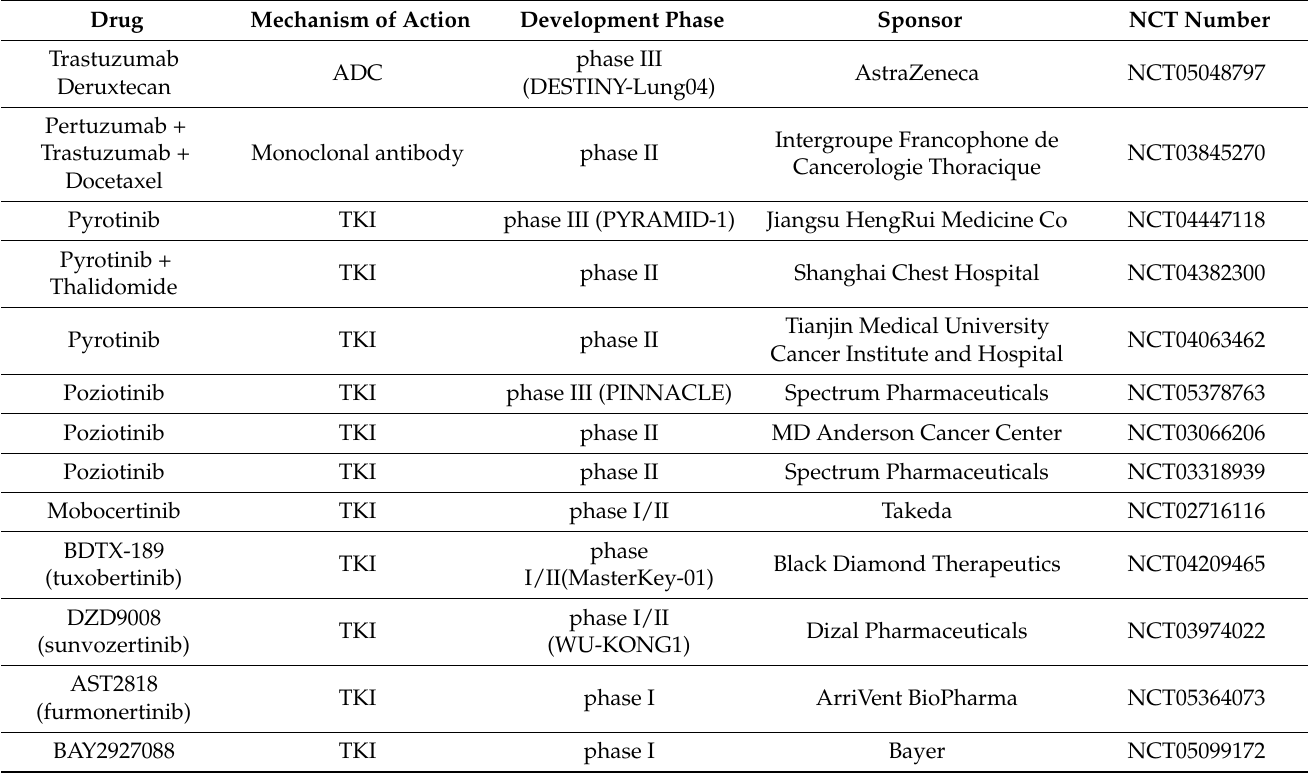
Table 4. Select Ongoing Clinical Trials in HER2 exon 20 mutation NSCLC patients.VI.